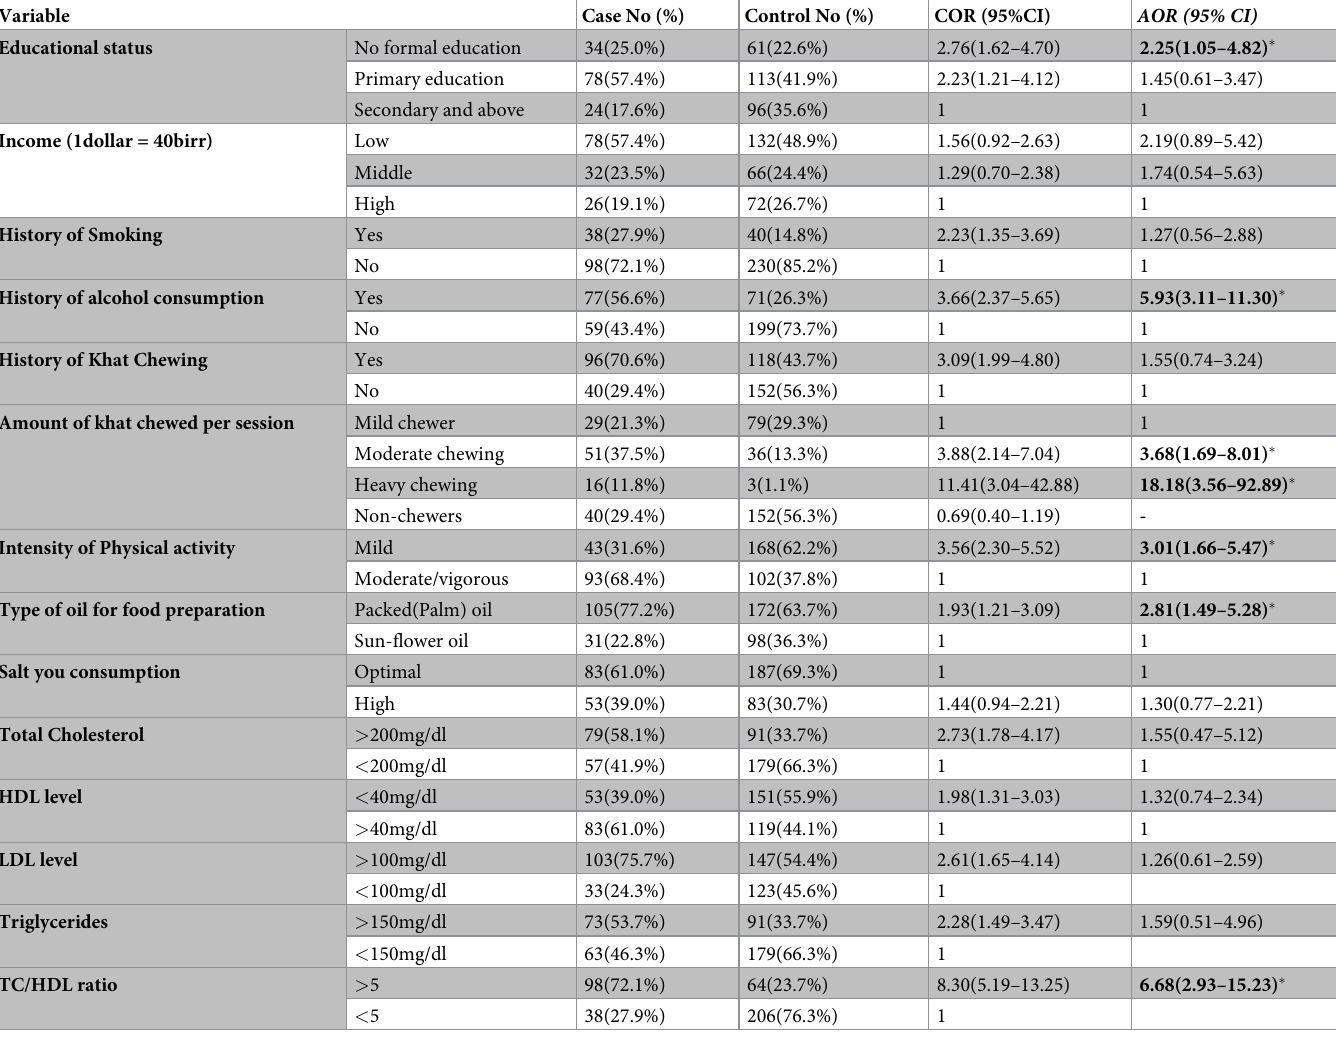
Table 3. Bivariate and multivariate logistic regression of heavy khat (Catha edulis) chewing and dyslipidemia as modifiable risk factors among patients in South- west, Ethiopia,